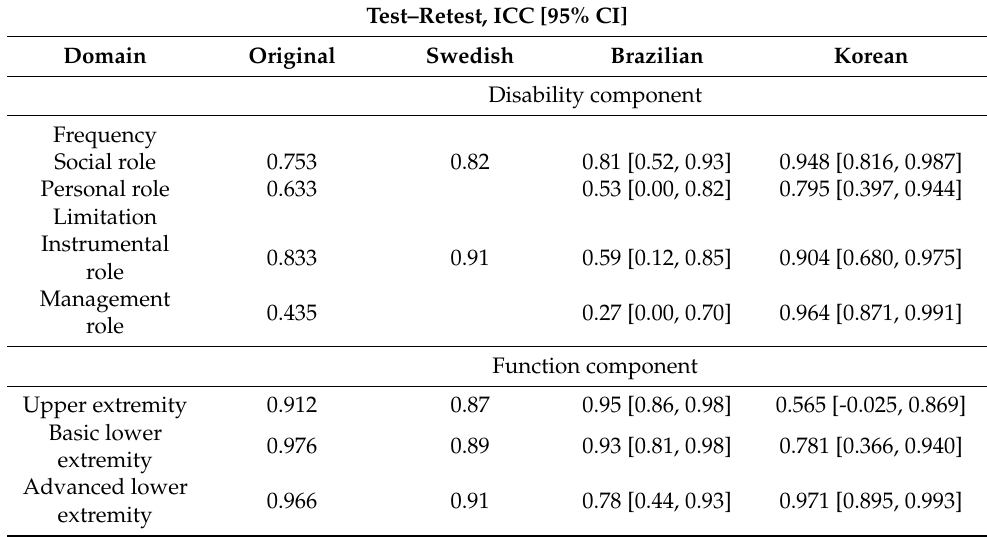
Table 2. Test–retest reliability of the K-LLFDI ( n = 50).